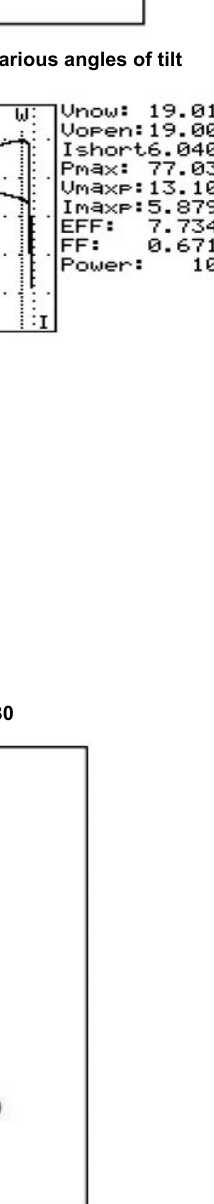
Figure [11]. Experimental comparison between the (PV) panel performance and the different tilt angles for day (16